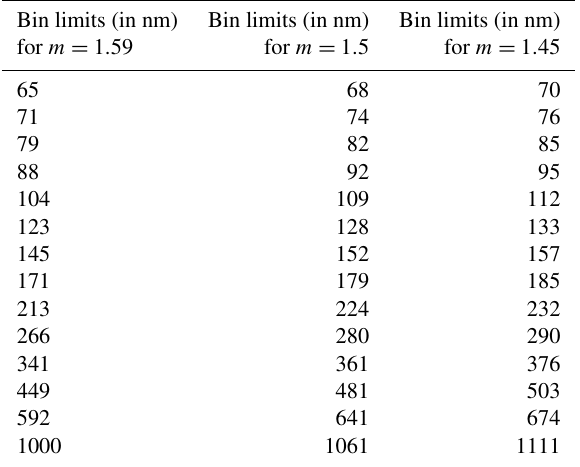
Table A1. UHSAS-A bin limits for the calibration with PSL parti- cles (refractive index m = 1 . 59), recalibrated for refractive indices of 1.5 and